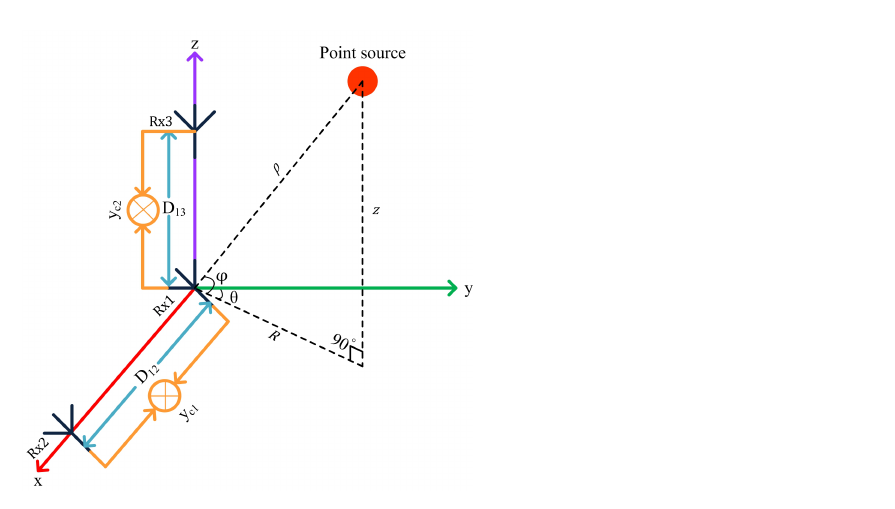
Figure 1. Geometry of the dual-orthogonal baseline interferometric radar with a point source in the 3D Cartesian